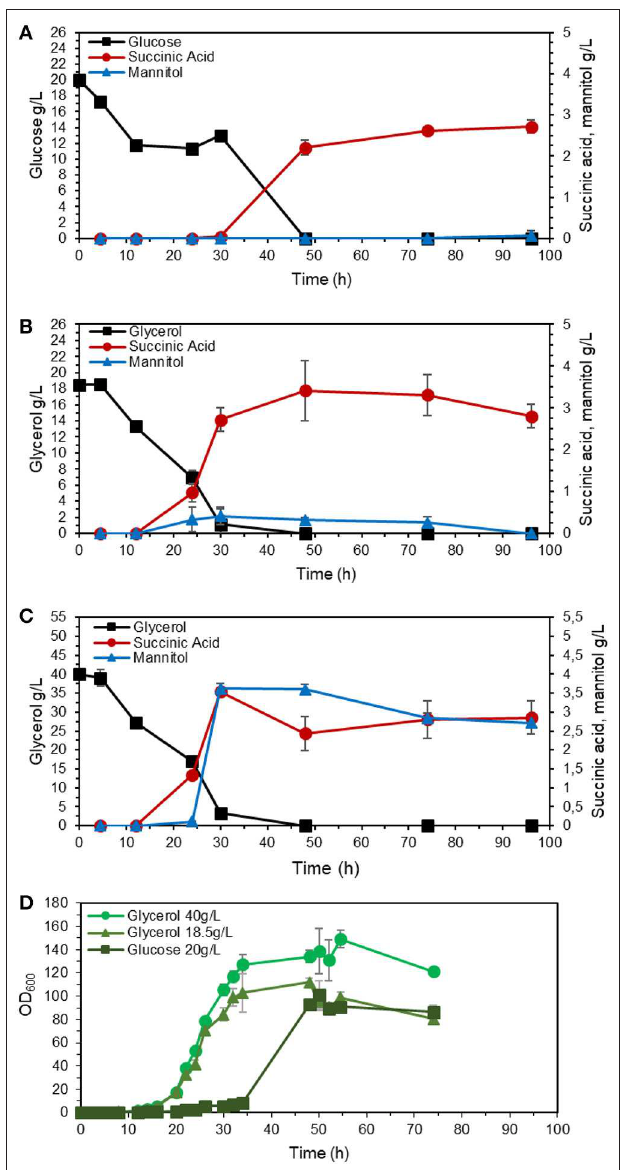
FIGURE 3 | Performance of succinate-producing strain (ST8578) on glucose or glycerol as carbon source. The strains were cultivated in shake flasks on YP medium with 20 g/L glucose monohydrate (A) , 18.5 g/L glycerol (B) , or 40 g/L glycerol (C) , with OD 600 profile showing the ability of the cells to grow on glucose with longer lag phase compared to glycerol (D) . The values are averages from three biological replicates, the error bars show the standard deviation.